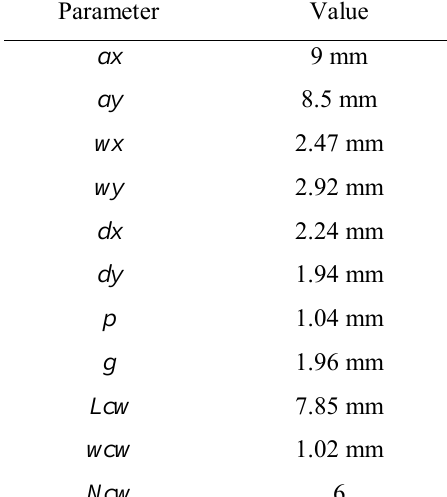
Table 1: Parameter values of designed unit cell.